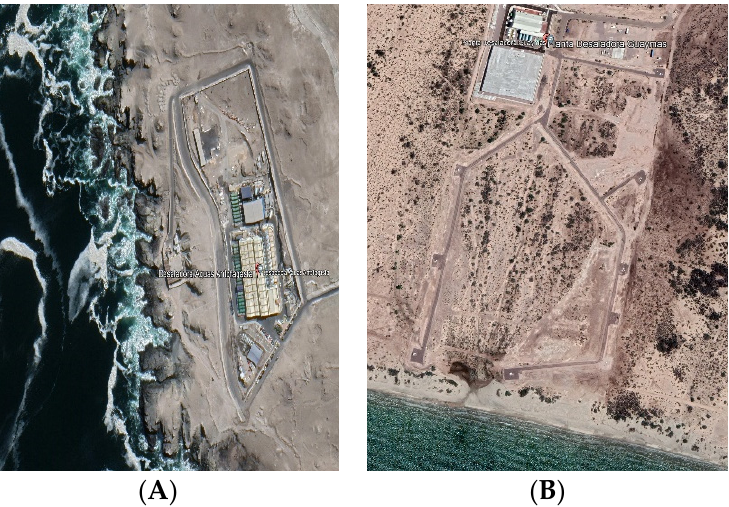
Figure 3. ( A ) Desalination plant in Antofagasta, Chile [29]. ( B ) Desalination plant in Guaymas, Sonora, Mexico